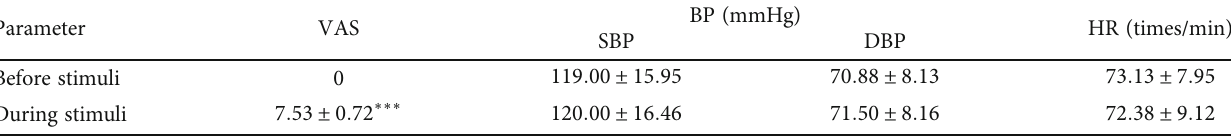
Table 1: Fundamental information of experimental subjects in the latent MTrP before and during stimuli.